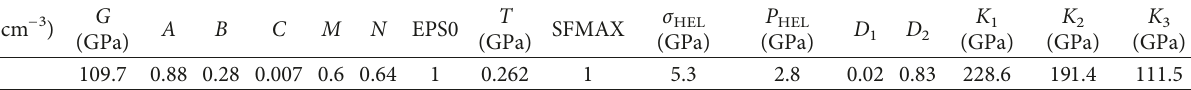
Table 8: JH2 material model parameters for ceramic [15].